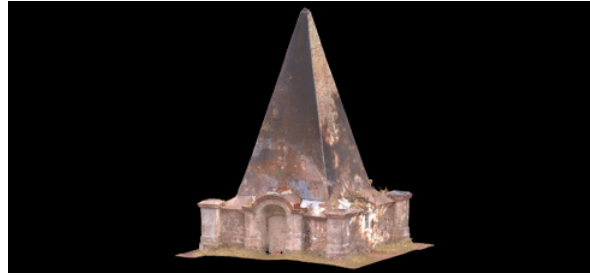
Figure 9. Point cloud of the building (created by M. Bura). During the study conducted in 2015, georadar surveys were also carried, using Mala's georadar (Ramac X3M model with shielded antenna 500Mhz). The echogram images were processed using Ramac Ground Vision 1.4.6 and Easy 3D. There were no anomalies within the building indicating the presence of underground voids. Anomalies of 2m x 1m and 1.2m deep in the form of a secondary buried excavation were found. The aforementioned anomaly is located directly in front of the walled entrance to the building. The long axis of the anomaly runs at right angles to the NW wall of the pyramid. Inside the facility an anomaly was demonstrated at a depth of about 1.4 m over which was found a second anomaly of the nature of the disturbance of the subsurface layers of the soil. A closer look at the character of the aforementioned anomaly will be possible after conducting a larger area investigation, which is related to the clearing of bricks and